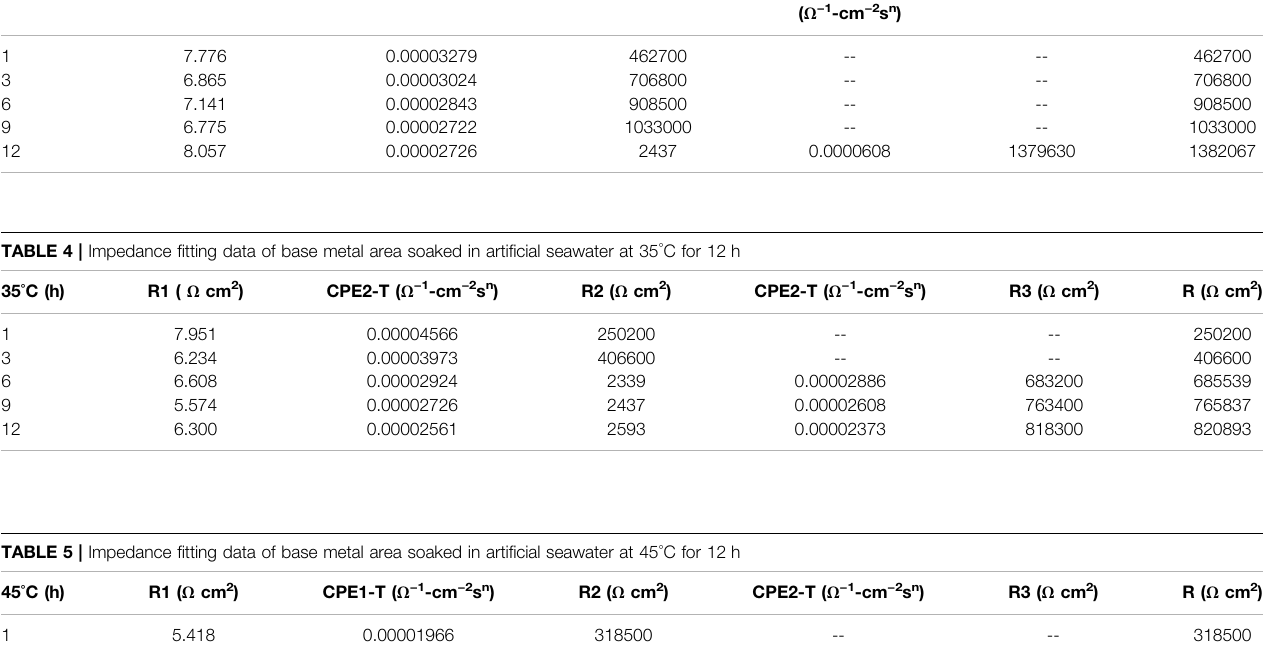
TABLE 3 | Impedance fi tting data of base metal area soaked in arti fi cial seawater at 25 ° C for 12 h 25 ° C (h)